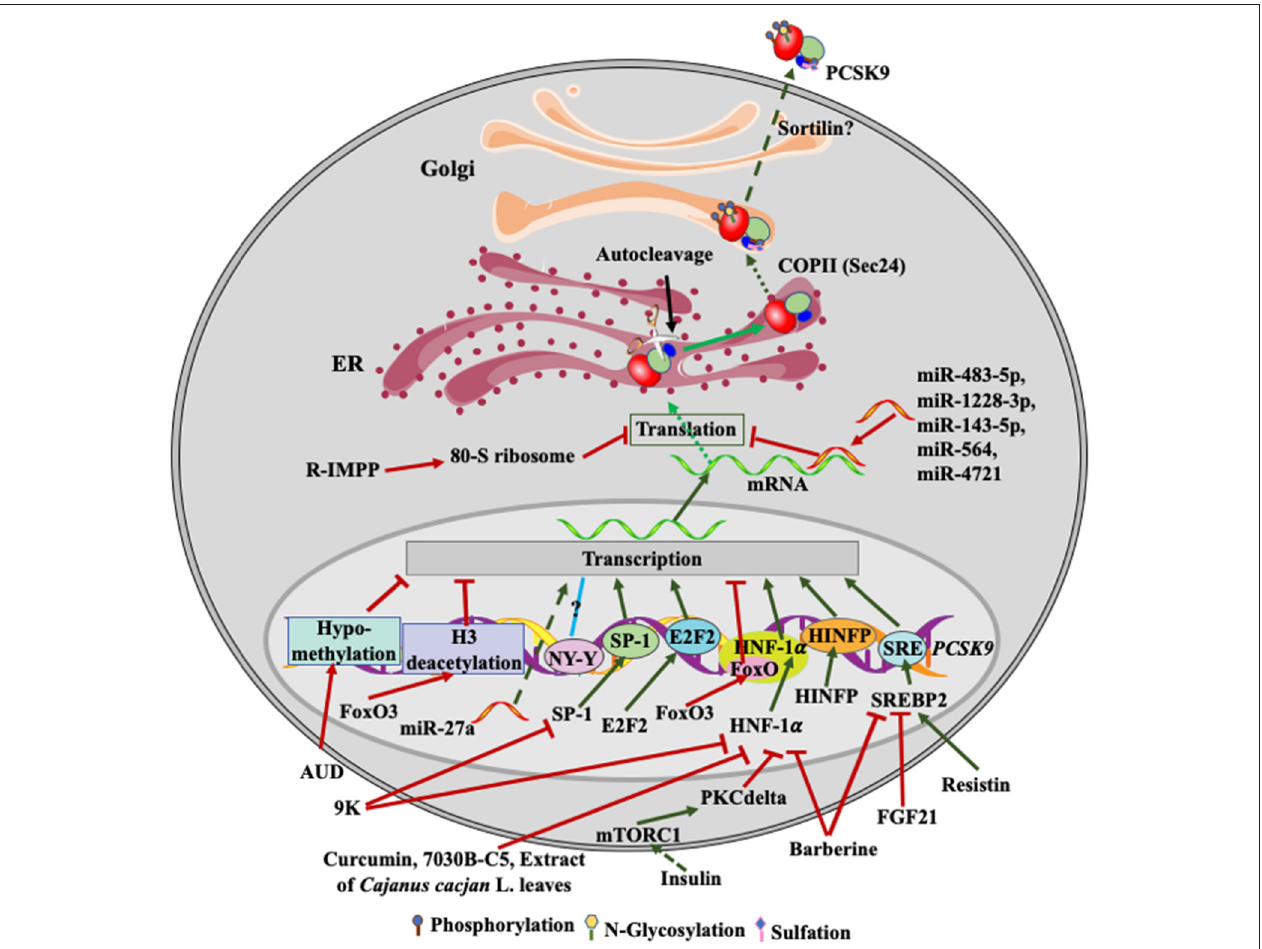
FIGURE 2 | Regulation of PCSK9 expression. Transcriptional factors, such as SREBP2, HNF-1 α , SP-1and E2F2, upregulate PCSK9 transcription. FGF21 and resistin inhibit and increase SREBP2-mediated transcription of PCSK9, respectively. Barberine reduces PCSK9 expression via suppressing the activity of SREBP2 and HNF-1 α on PCSK9 transcription. 9K suppresses PCSK9 expression through SP1 and HNF-1 α , while Curcumin, 7030B-C5 inhibits HNF-1 α -induced transcription of PCSK9. Alcohol use causes hypomethylation of PCSK9 promoter and then reduces PCSK9 expression. Insulin activates mTROC1 and then PKC δ to